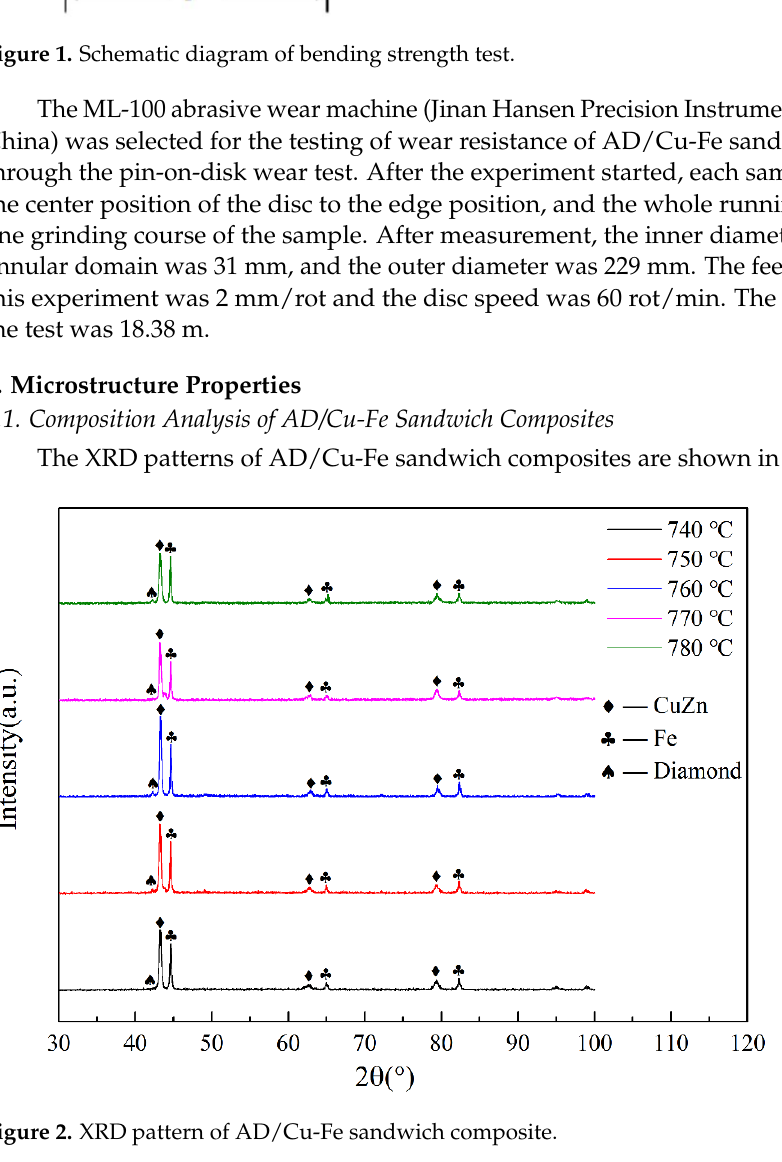
Figure 1. Schematic diagram of bending strength test.